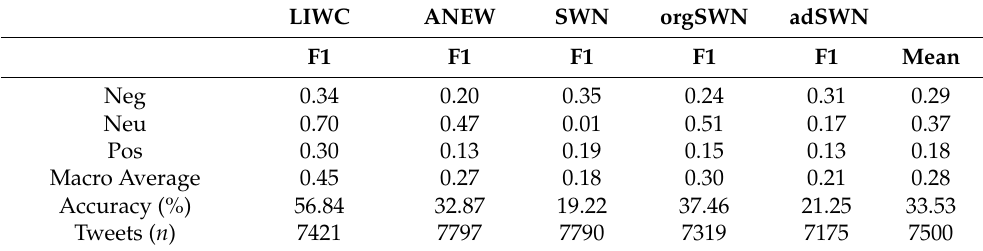
Table 2. Validity evaluation in comparison with manual coding results. LIWC ANEW SWN orgSWN